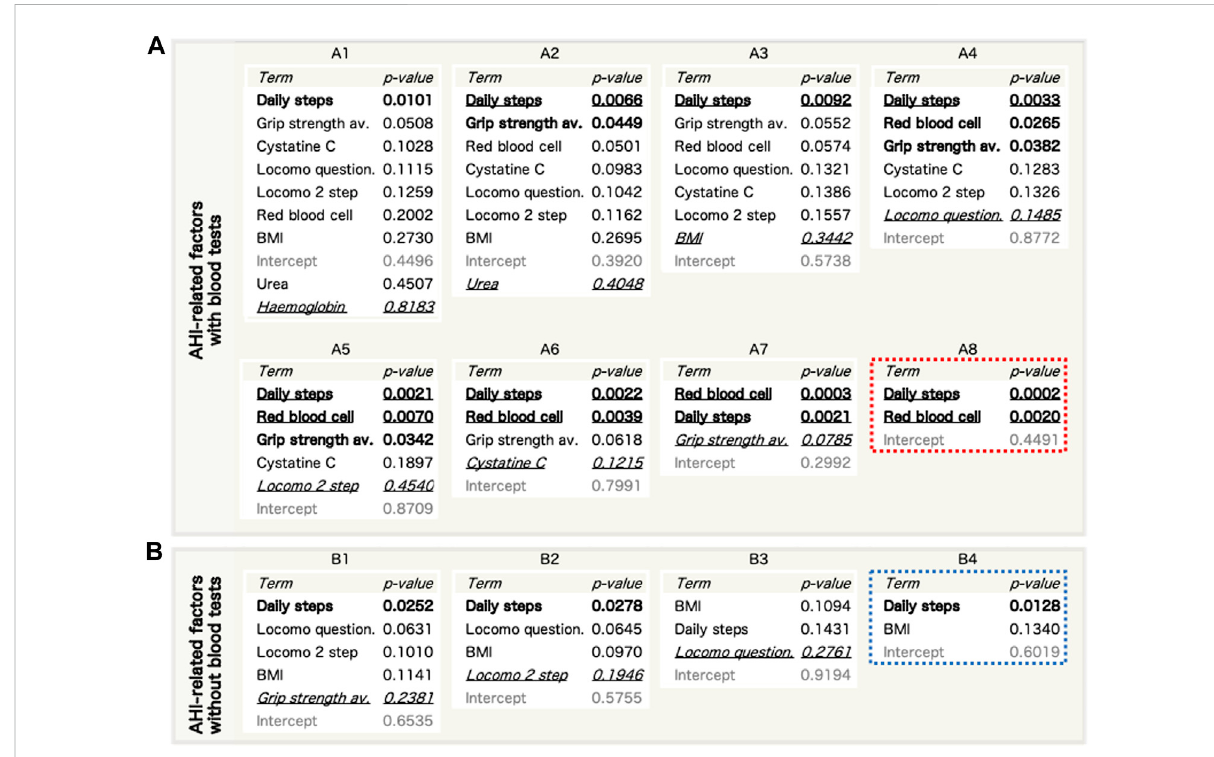
FIGURE 3 Re fi nementofAHI-relatedfactorsbystepwisereductionofusedfactorsusingamultiplelinearregression(MLR)model. (A,B) Theentirestepsof reduction for AHI-related factor sets with blood factors (a, sets A1 – 8) and without blood factors (b, sets B1 – 4). Bold: p < 0.05. Bold and underlined: p < 0.01. Italic and underlined: the worst p -values in each set that were excluded in the next step. c, Re fi nement of AHI-related factor sets without blood factors. AHI, apnoea-hypopnoea index; BMI, body mass